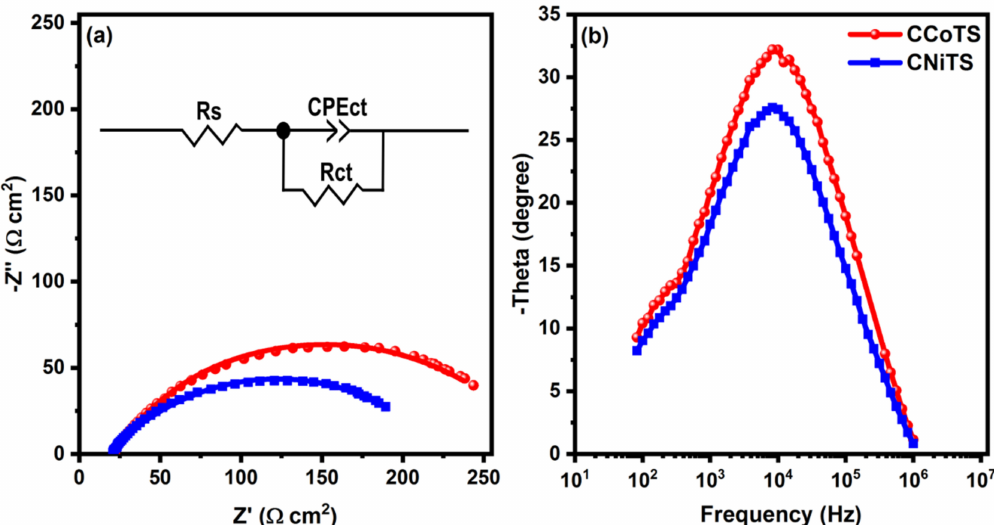
Figure 3. ( a ) Nyquist plots and ( b ) Bode plot of the CM(M = Ni, Co)TS-PSCs under illumination (AM 1.5 G) at the biased voltage of 0.8 V; solid lines show the fitting curves according to equivalent circuit depicted in the